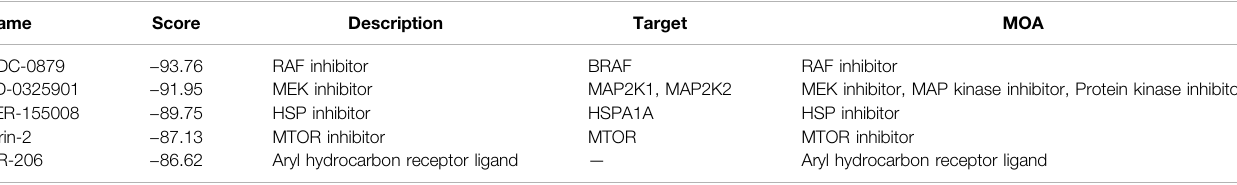
TABLE1| Listofthe fi vemostsigni fi cantsmallmolecularcompoundstopotentiallyreversealteredexpressionofdifferentiallyexpressedgenes(DEGs)inthehigh-riskgroup.